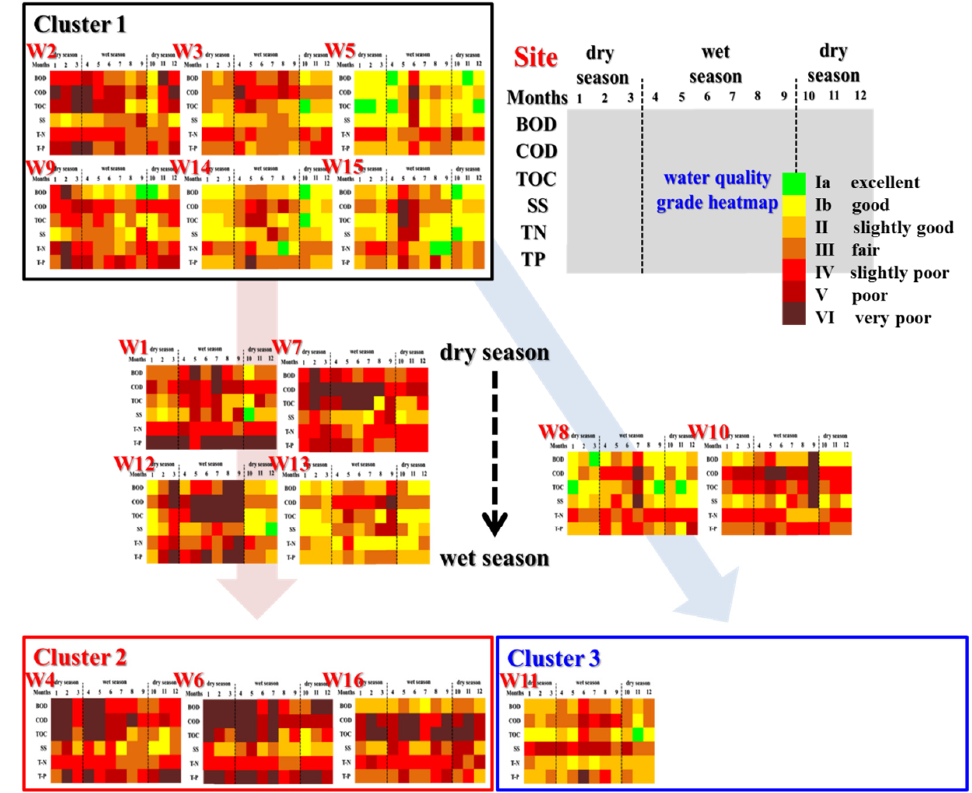
Figure 3. Heatmap showing the quality grade of coastal streams and seasonal changes in the cluster of coastal streams.